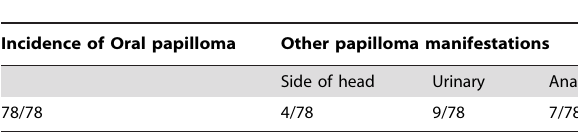
Table 1. Incidence of oral and other papillomas in K- Ras G12D ; K14-Cre:ER